Question: Provide a one-line summary of what is displayed.
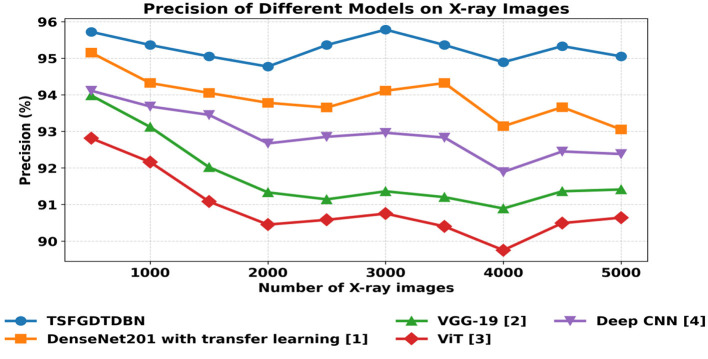
Answer: Performance analysis of precision using Multi-Class Knee Osteoporosis X-ray Dataset.